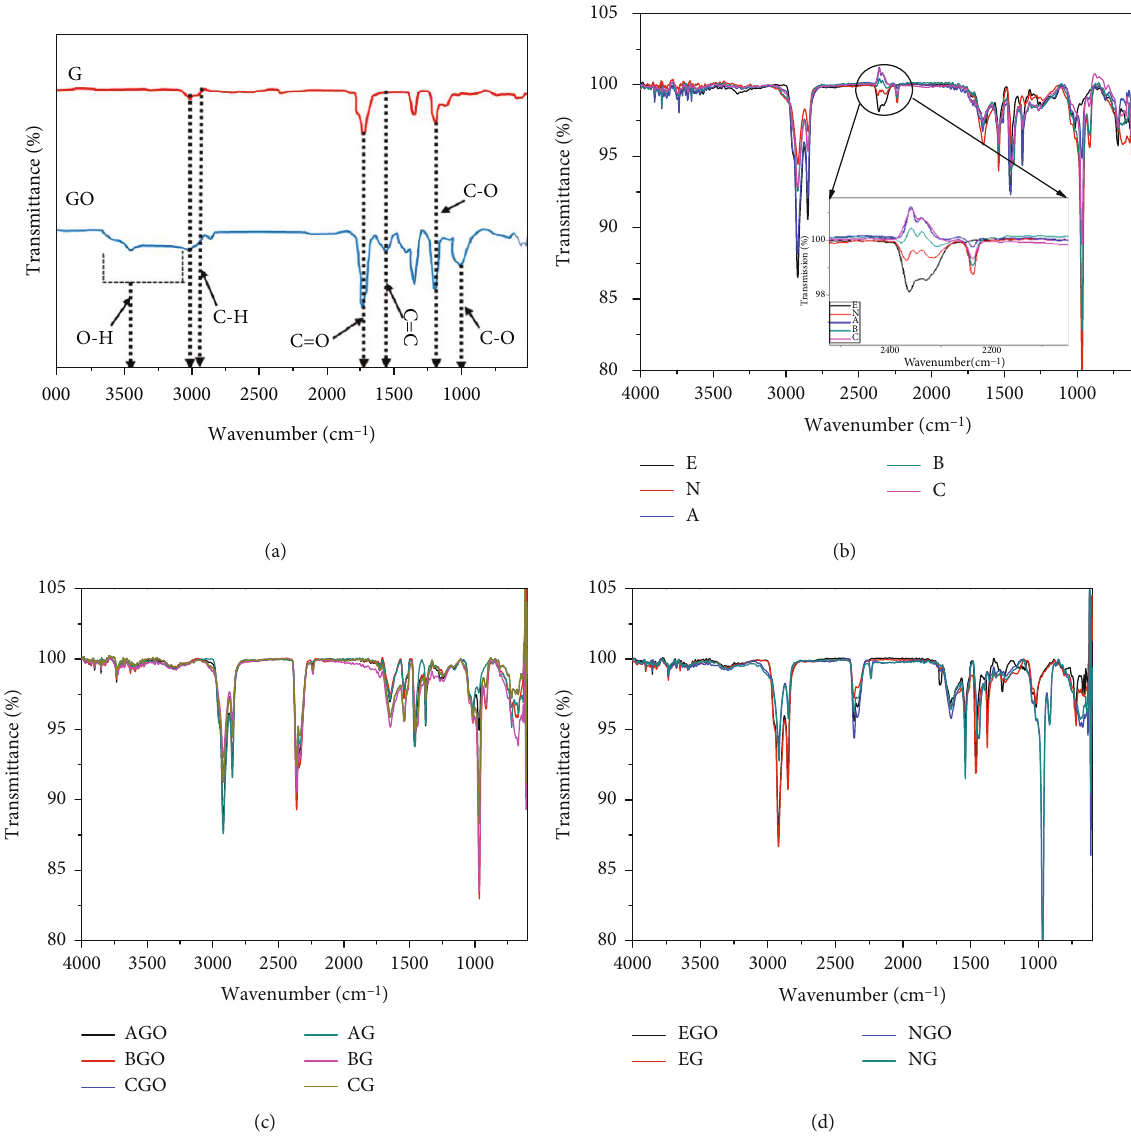
Figure 3: FTIR spectra of rubber compounds (a) GO and G, (b) un fi lled-single and double matrices, (c) fi lled double matrices, and (d) fi lled single